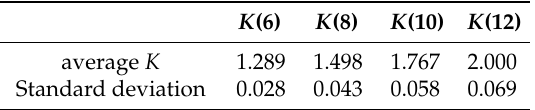
Table 3. Ratio of characteristic curve and baseline at different distances (in cm).